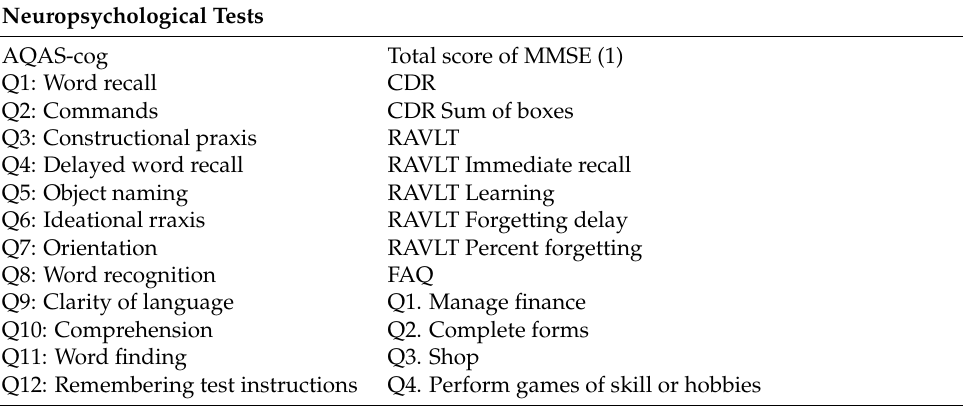
Table A1. Neuropsychological tests used in this